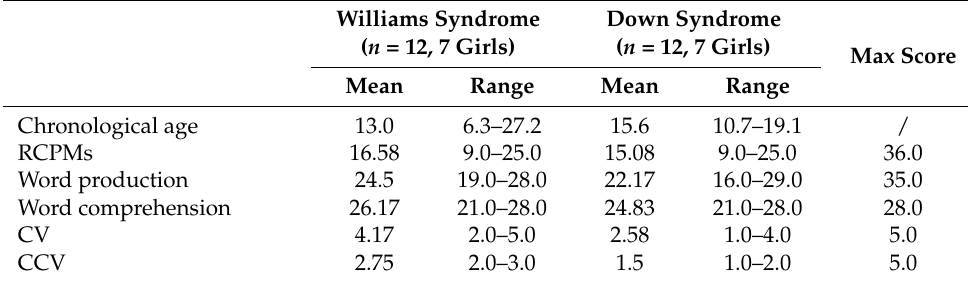
Table 1. Participants’